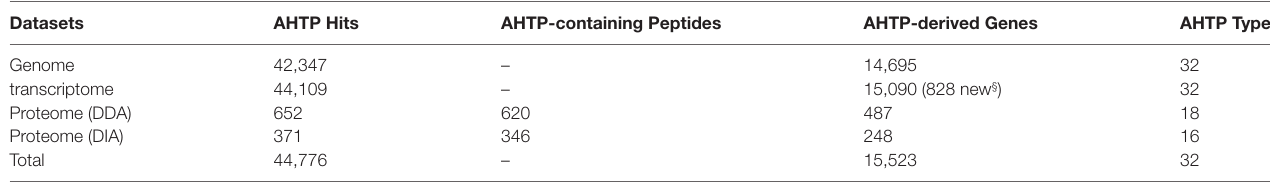
TABLE 1 | Statistics of the identified AHTPs from multi-omics data of the lined seahorse.